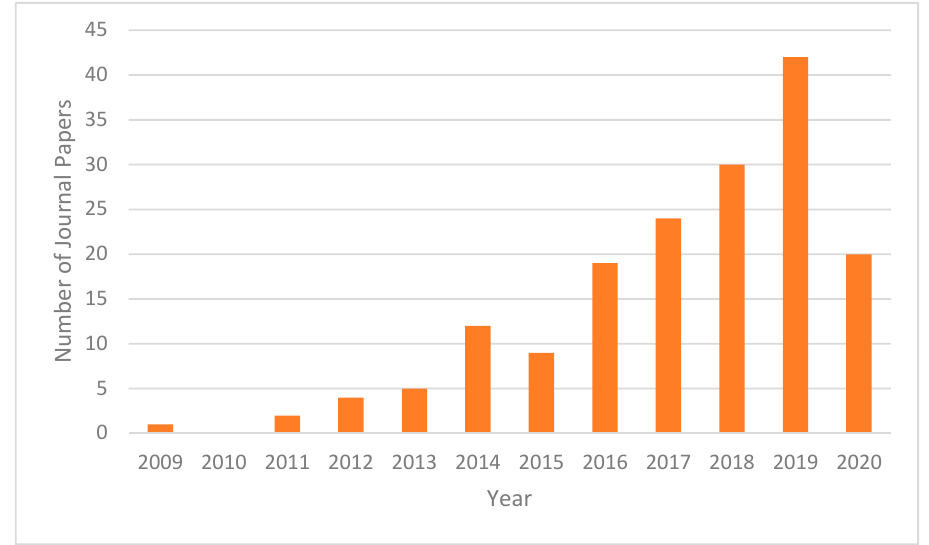
Figure 1. Papers published in ScienceDirect journals on bacterial concrete per year since 2009.